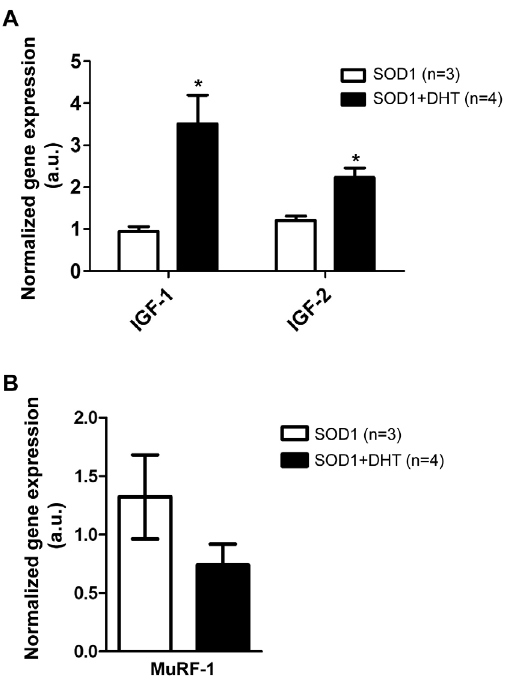
Figure 4. DHT increases the expression of insulin-like growth factor -1 and -2, while decreases MuRF-1 expression. A: The TA muscles were collected from DHT-treated SOD1 and control SOD1 mice at P120 to check the expression of insulin-like growth factor (IGF) -1 and IGF-2 through quantitative RT-PCR. DHT-treated SOD1 mice showed increased expression of IGF-1 and IGF-2, by approximately 4-fold ( p =0.0261), and 2-fold ( p =0.015), respectively, compared with control SOD1 mice. * p , 0.05. B: By using quantitative RT-PCR, we found that DHT-treated SOD1 mice showed a trend of decreased expression of MuRF-1 by 44% compared with control SOD1 mice ( p